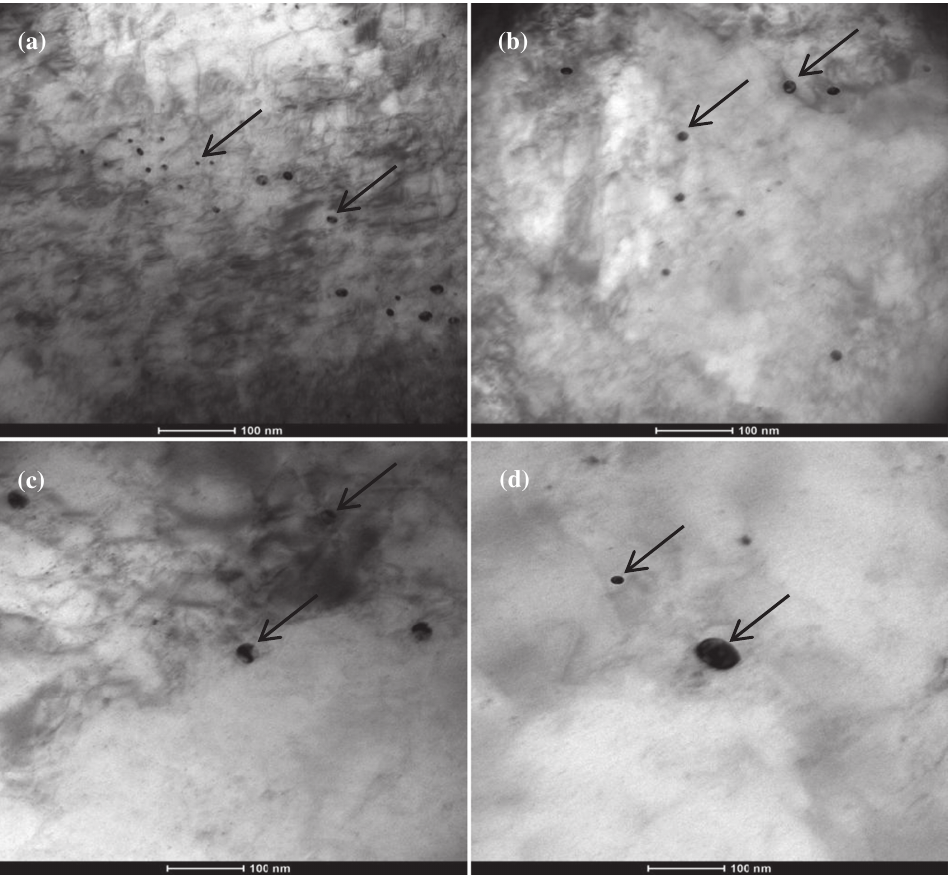
Figure 9: V(C, N) precipitates TEM micrographs of samples deformed under temperatures from 850°C to 1,000°C (a) 850°C (b)